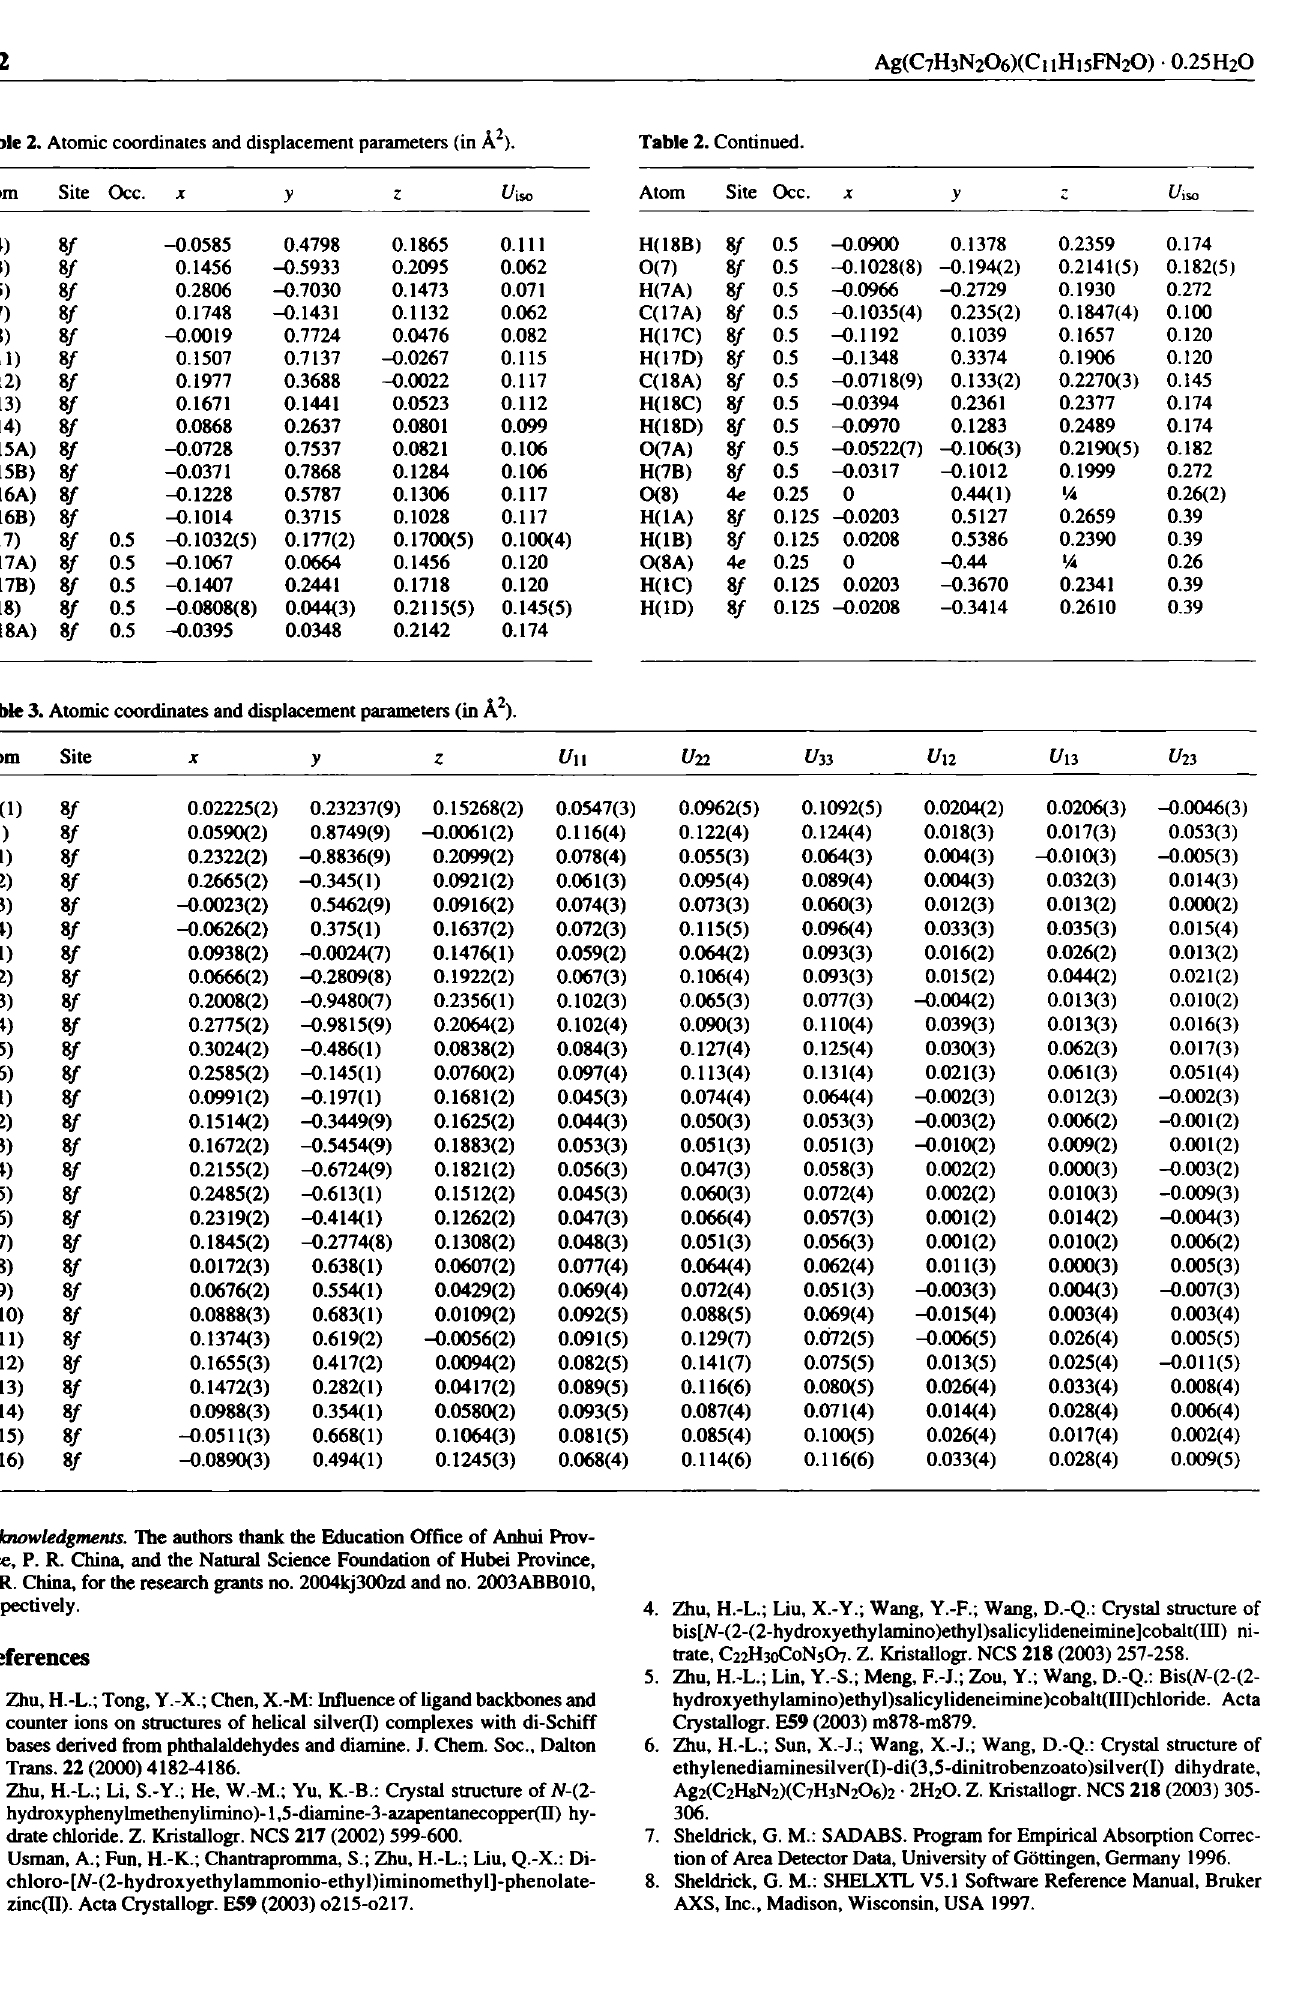
Table 3. Atomic coordinates and displacement parameters (in Â 2